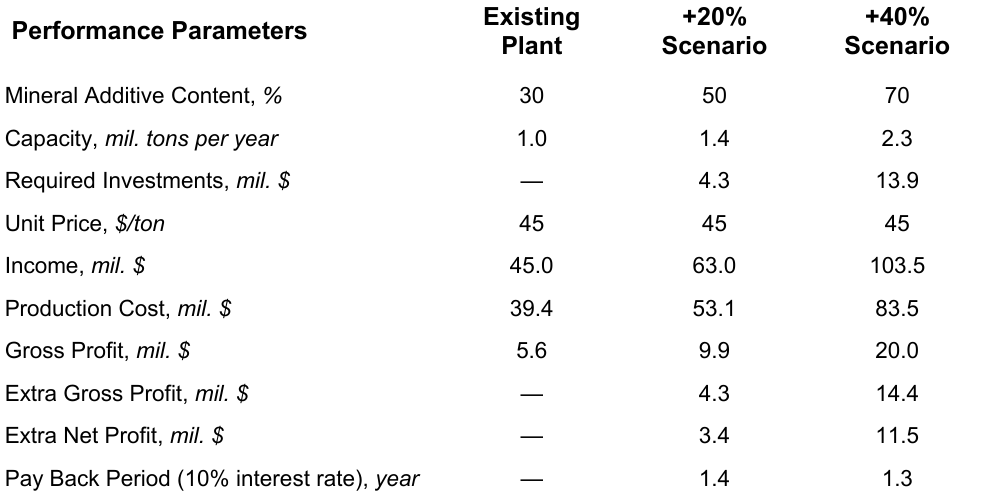
Expanding an Existing Cement Plant: Case of HVMA Cement[43] Performance Parameters